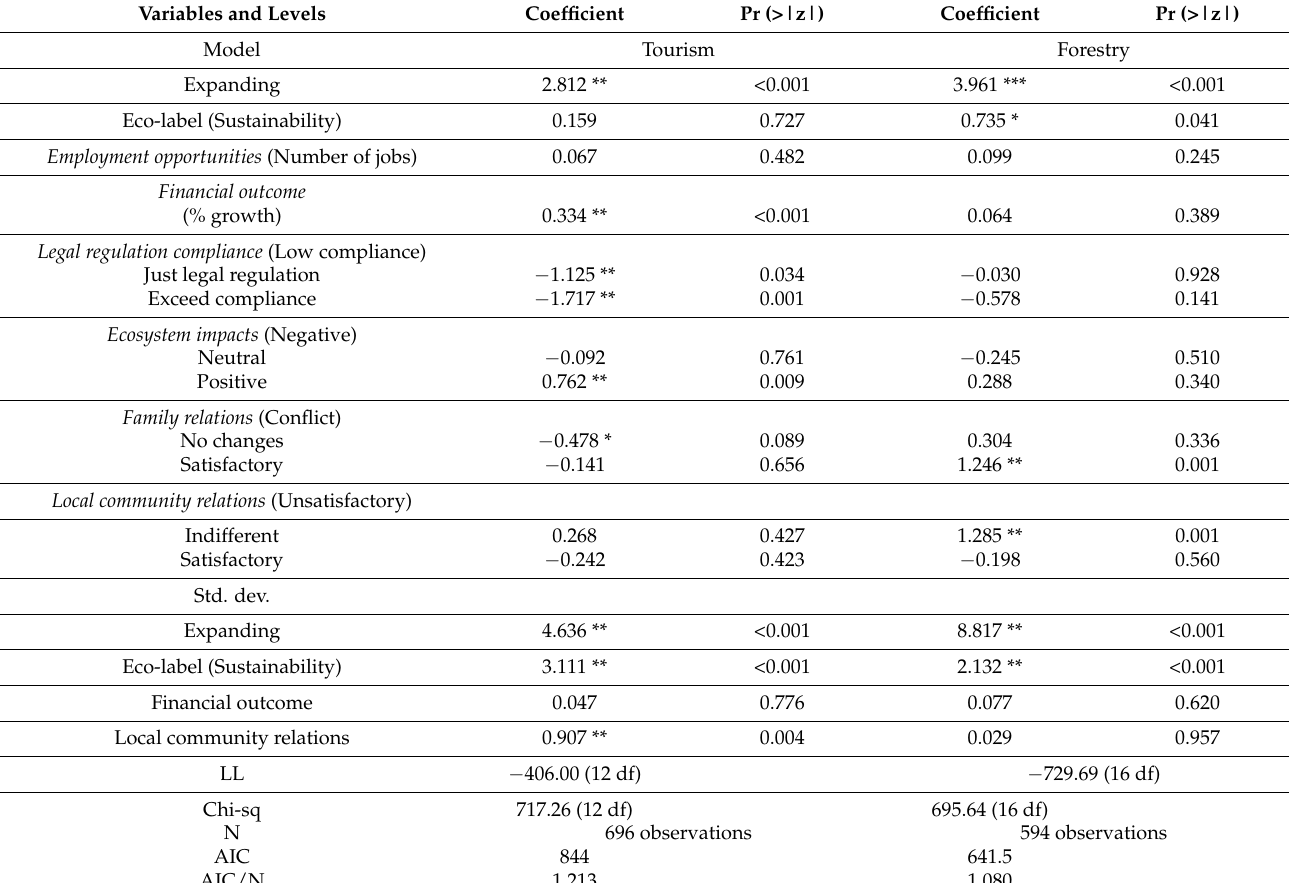
Table 5. RPL Models by